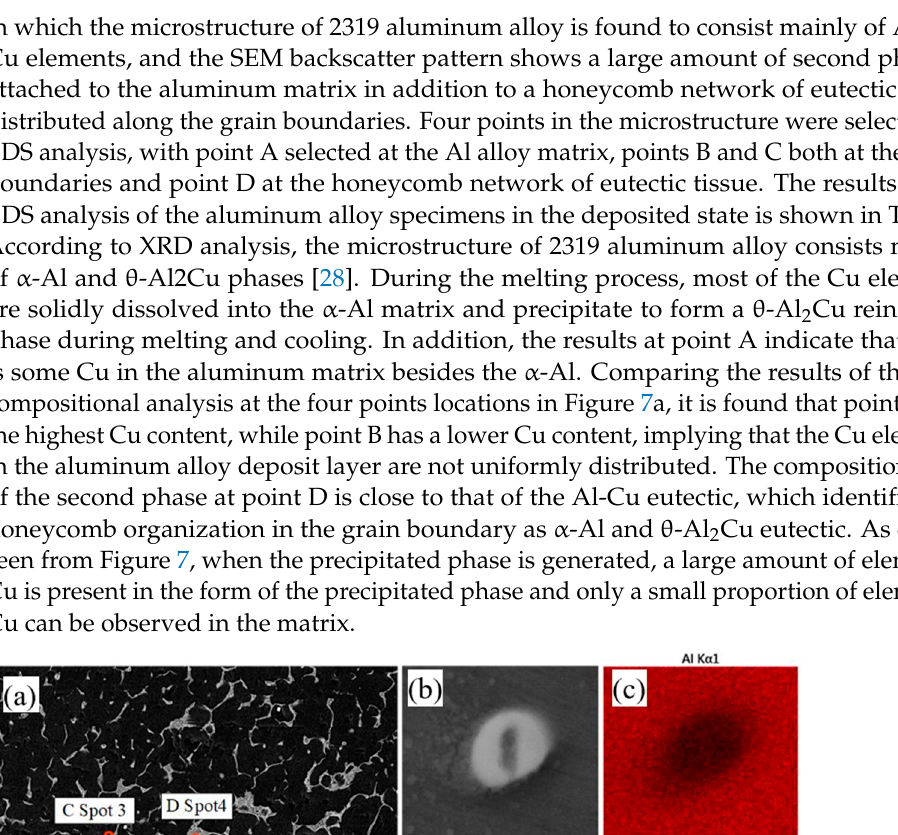
Figure 6. Macroscopic morphology and energy spectrum analysis of B 4 C powders.